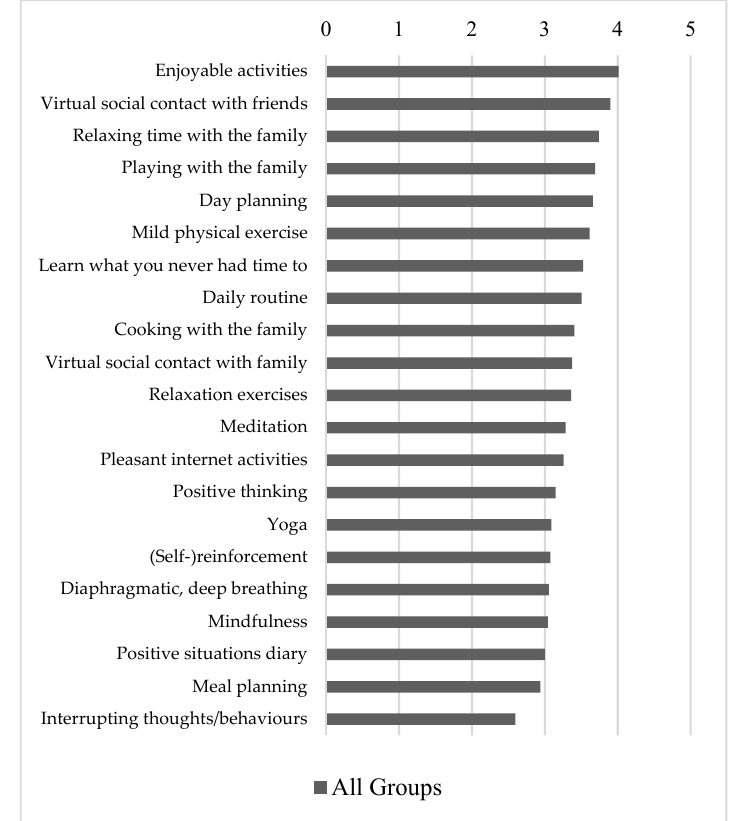
Figure 3. Responses on helpfulness of coping strategies (when used) for all groups (1 = not helpful, 2 = a little helpful, 3 = fairly helpful, 4 = helpful, 5 = very helpful) sorted by degree of helpfulness.